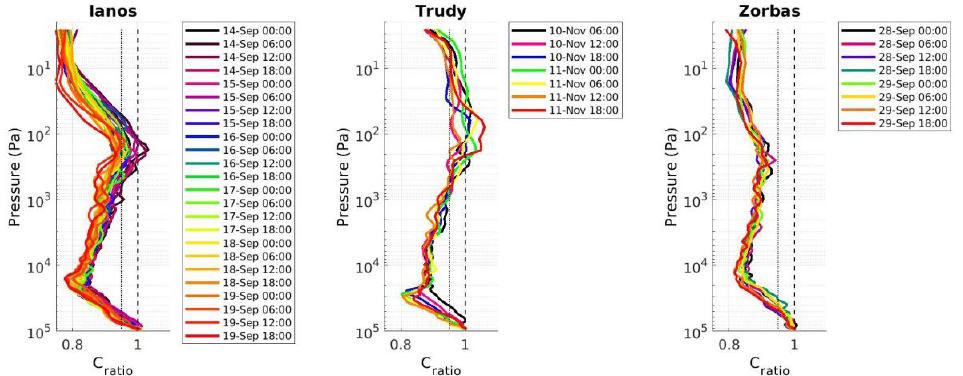
Figure 10. Vertical profiles of c ratio derived using ERA5 fields at the infrasound station IS48 during Medicane Ianos in 2020 ( left ), Medicane Trudy in 2019 ( middle ), and Medicane Zorbas in 2018 ( right ). The vertical dashed line indicates the value c ratio = 1, which is a necessary condition for infrasound guiding in the geometric acoustics approximation. The dotted line indicates c ratio = 0.95.